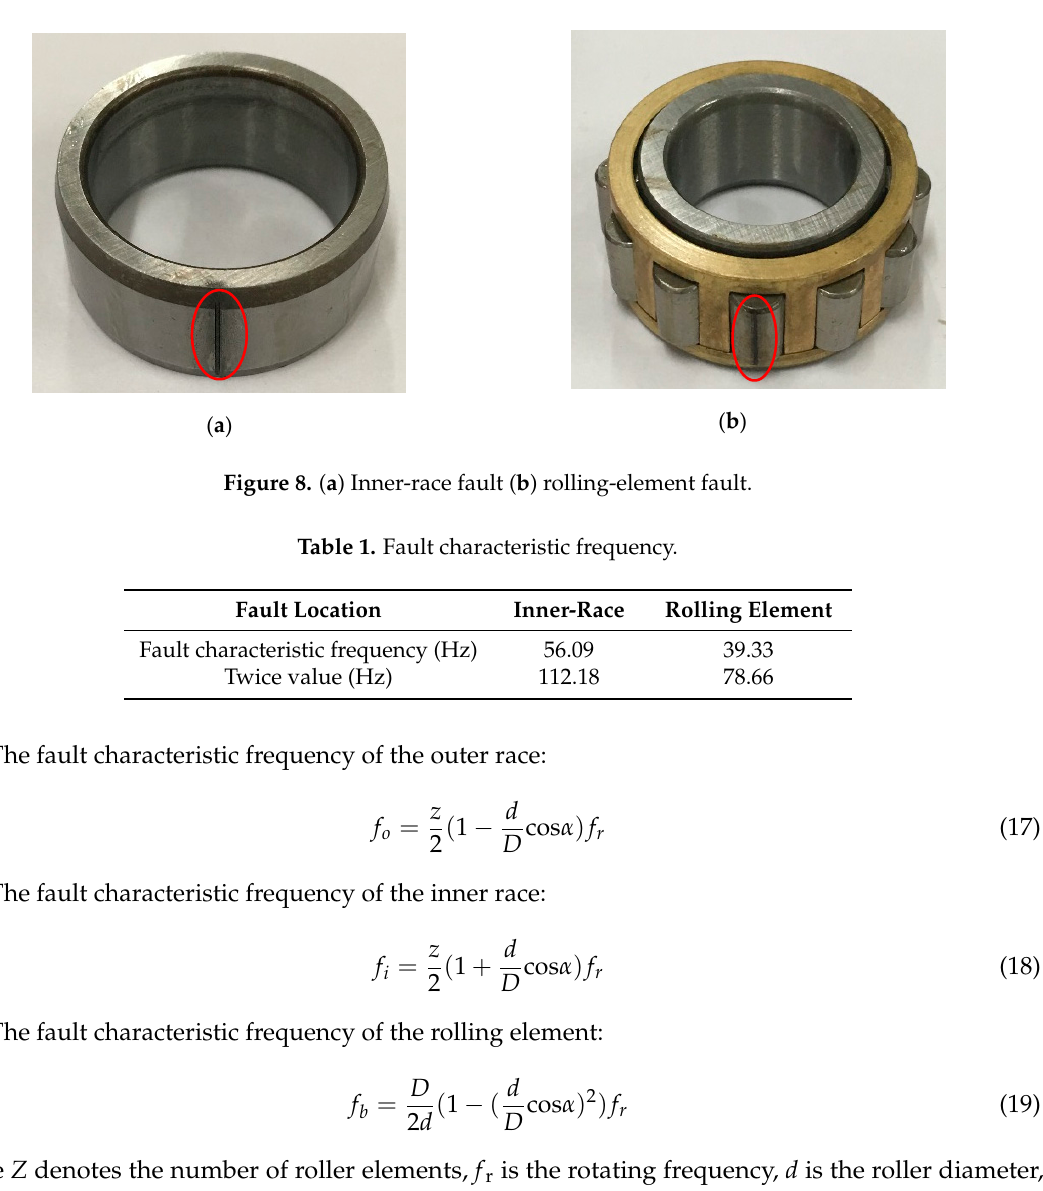
Figure 7. ( a ) Fan system ( b ) Flow diagram of the fan system ( c ) Location of the sensors.